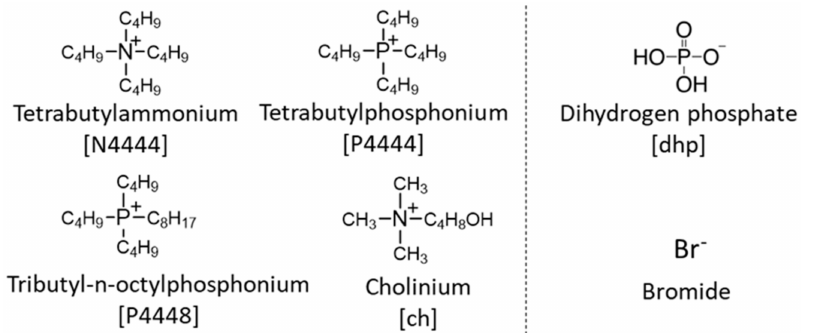
Figure 1. Structure of cations and anions for ionic liquids (ILs) used in the present